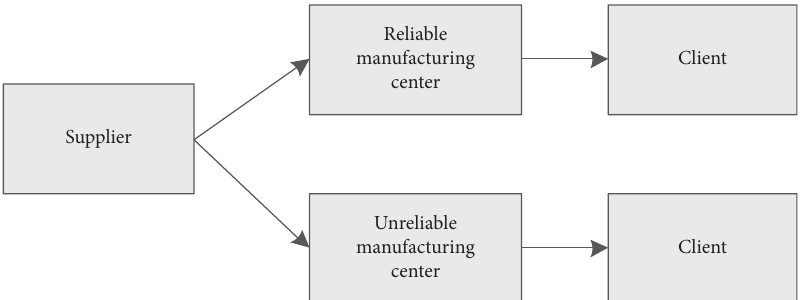
Figure 2: Three-level global supply chain network